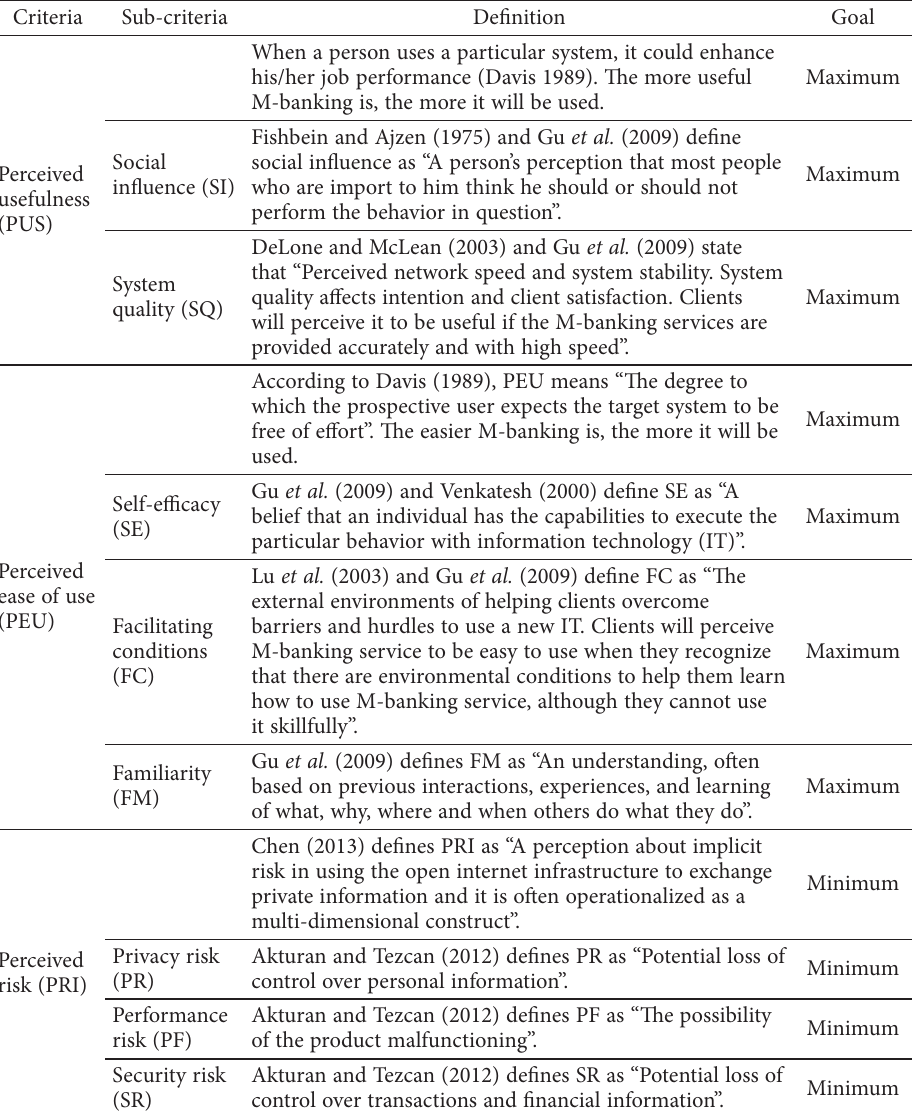
Table 5. M-banking adoption factors as evaluation criteria